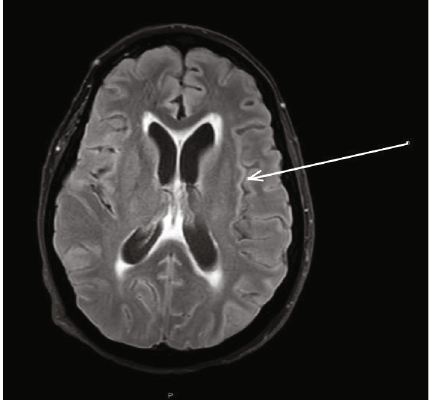
Figure 2: T2 sequence revealing hyperintensity in the walls of both lateral ventricles, as well as subtle communicant hydrocephalus (please see the